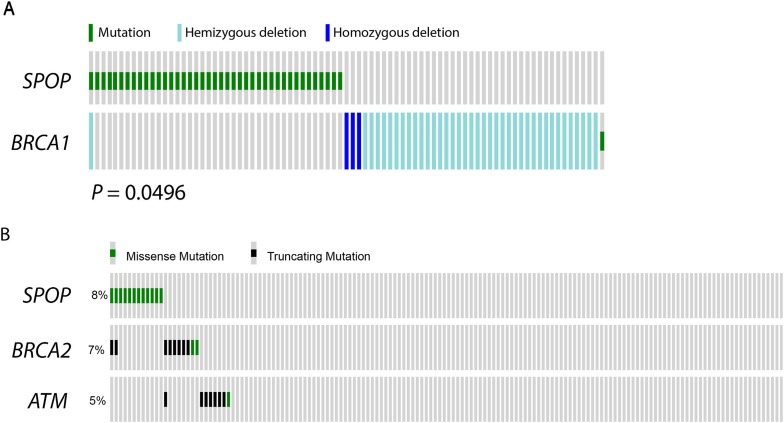
SPOP mutation and alterations in DNA repair genes in prostate cancer.(A) SPOP mutation and somatic BRCA1 gene alterations are mutually exclusive in primary prostate cancer. The cBio portal oncoprint tool was used to graphically summarize the mutations in SPOP and genomic deletions and mutations in BRCA1 in 402 human prostate cancer samples. Samples with no alterations are not displayed. SPOP mutations and BRCA1 alterations are mutually exclusive (one-tail Fisher's test, p-value = 0.0496). (B) SPOP mutation and DNA repair pathway alterations in castration-resistant prostate cancer. The cBio portal oncoprint tool was used to graphically summarize the mutations in SPOP and mutations in BRCA2 and ATM in 150 metatstaic castration-resistant prostate cancer samples.